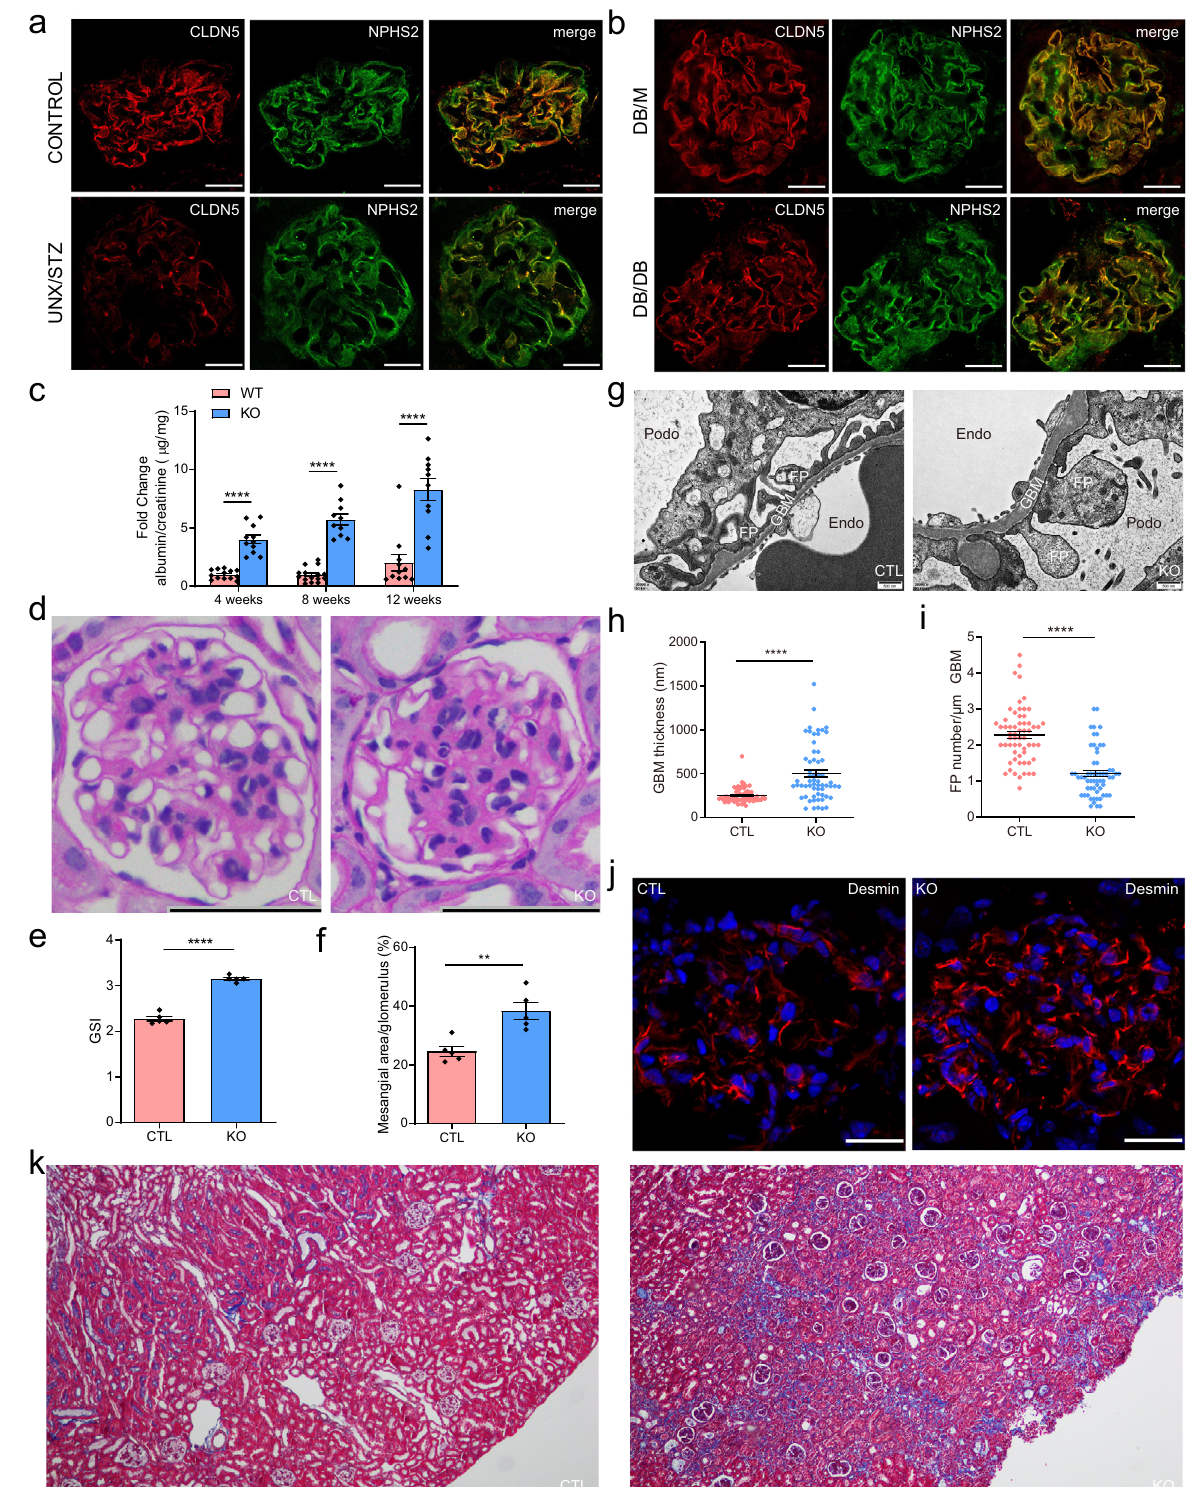
Cldn5 deletion in podocytes accelerates DN progression . To determine whether CLDN5 has a role in diabetic kidney disease, we fi rst studied the expression of CLDN5 in two mouse models of DN, the unilateral nephrectomy (UNX) combined with strepto- zotocin (STZ)-induced type I diabetic mice and DB/DB type 2 diabetic mice, by double immunostaining for CLDN5 and NPHS2. In both strains, we found that the expression of